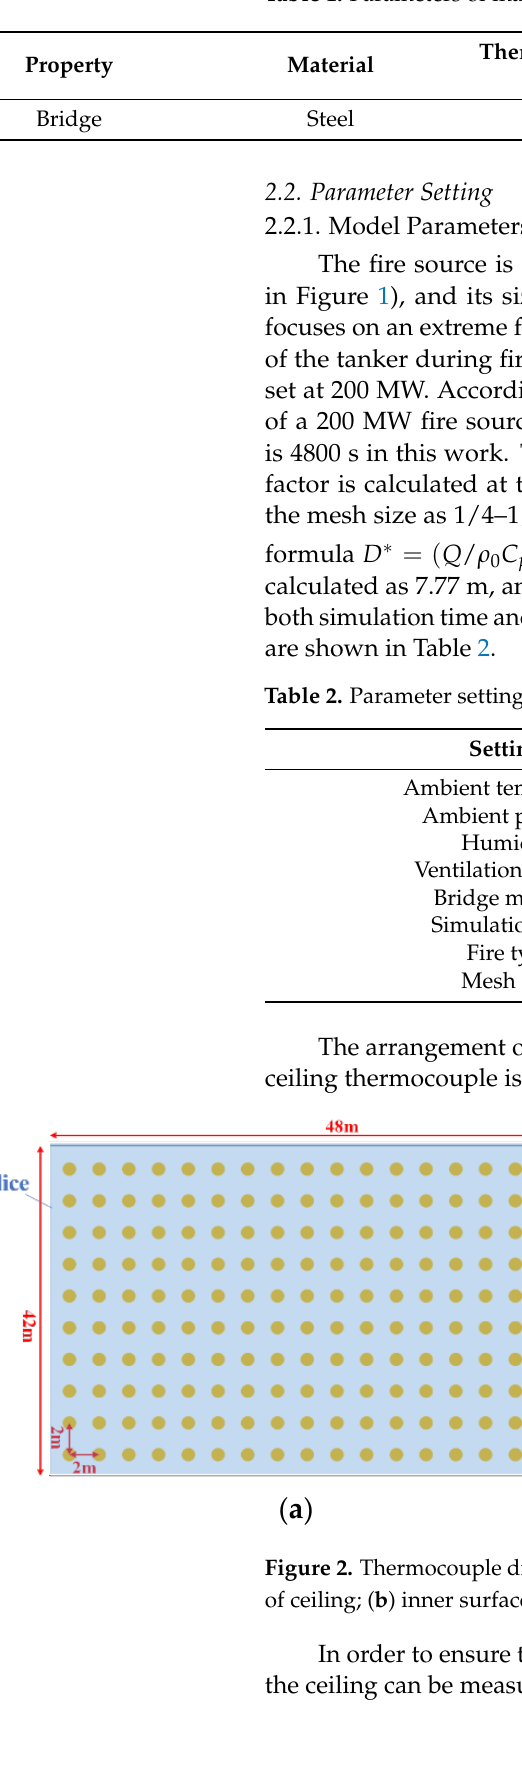
Table 1. Parameters of materials used in the bridge model.